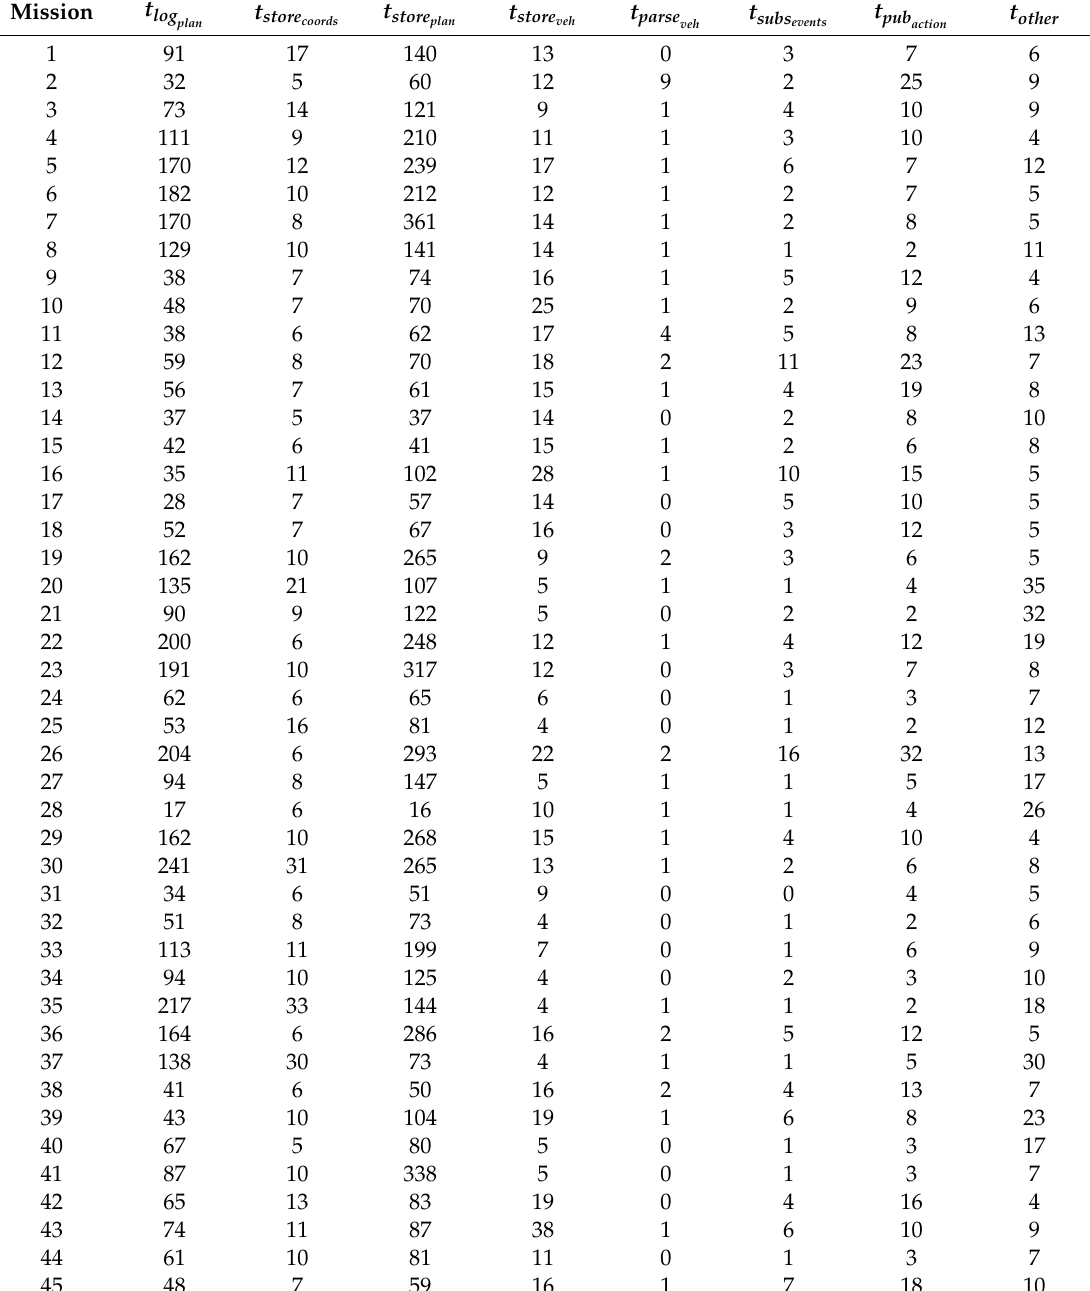
Table 4. Times for starting a mission in the MTRR after receiving it from the Mission Management Tool (MMT,